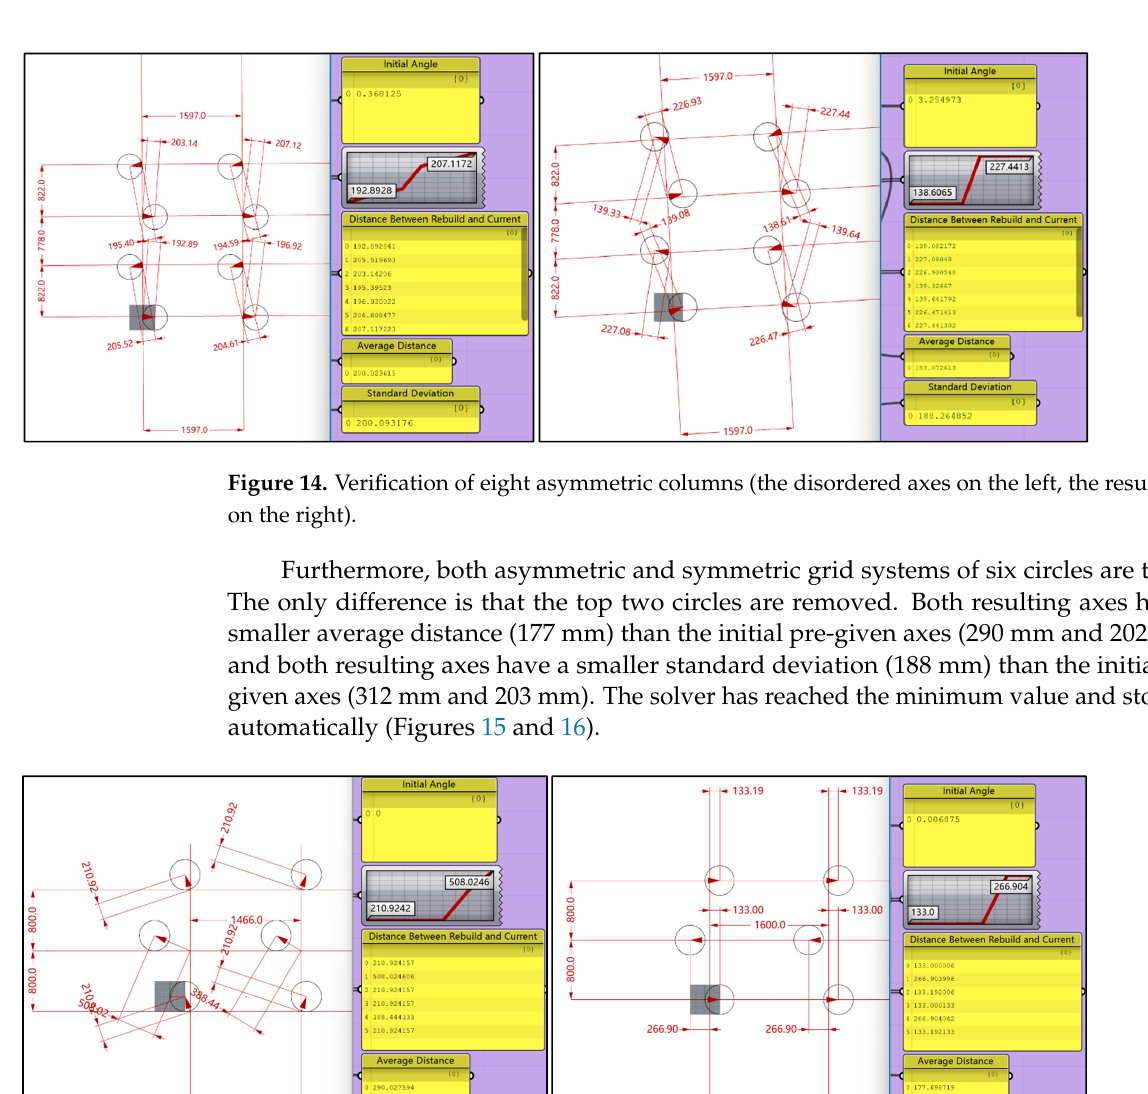
Figure 13. Verification of eight symmetric columns (the disordered axes on the left, the result axes on the right).